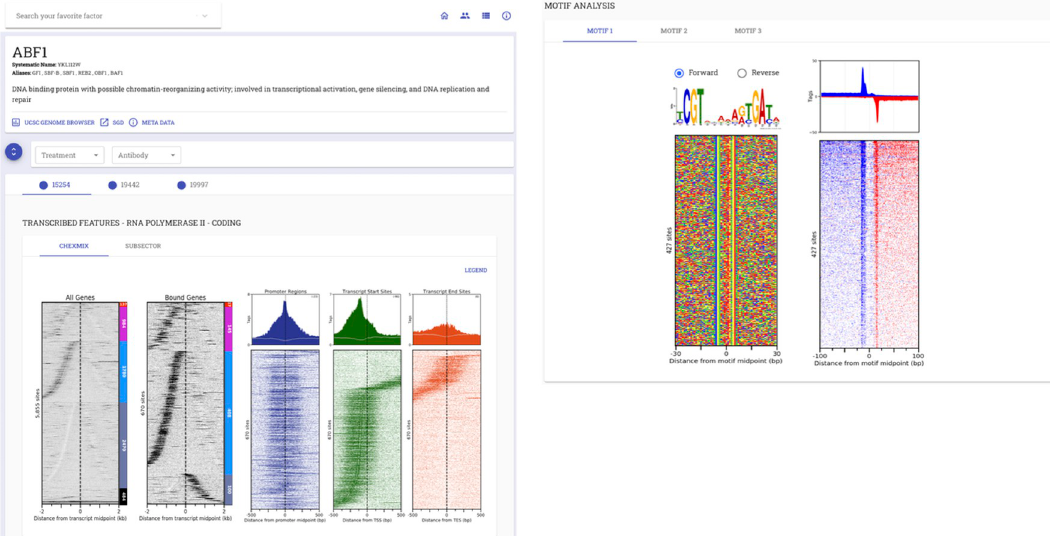
Fig 4. STENCIL application in PCRP. Application of STENCIL in the PCRP was an NIH-initiated project to screen 800 antibodies in ChIP-exo. NIH project requirements included providing the generated data in a community-accessible manner.